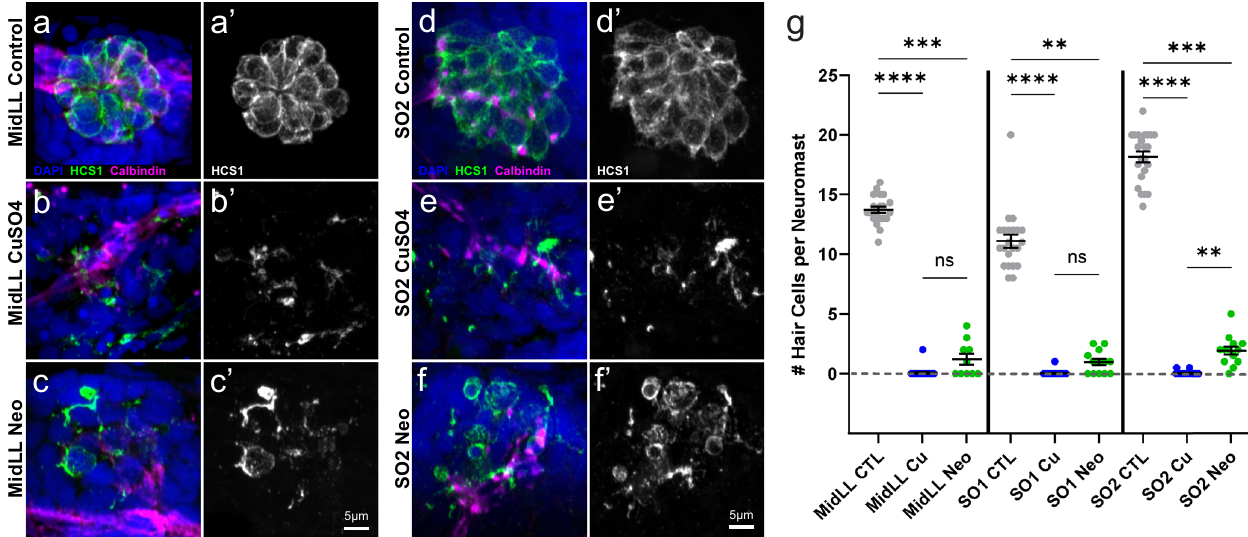
Fig. 2 Con fi rmation of neuromast hair cell loss following CuSO 4 or neomycin treatment. a – f Representative confocal max intensity projection images of the: a – c ) mid posterior lateral line (MidLL) fourth neuromast (L4); and d – f second anterior supraorbital (SO2) neuromast from the fi sh cohorts used for behavior experiments. Hair cells were labeled with an antibody against Otoferlin (HCS1; green a – f , gray a ′ – f ′ ). Afferent neurons were labeled with an antibody against Calbindin (magenta), and cell nuclei were labeled with DAPI (blue). g Quanti fi cation of the grand mean (±SEM) number of hair cells per neuromast in intact (CTL), CuSO 4 - and neomycin-treated fi sh. Each dot represents the mean number of hair cells from the MidLL (L3, L4, and L5) or SO (left and right) neuromasts from an individual fi sh. Data were collected from fi sh used in three experimental behavior trials; n = 4 – 6 fi sh per condition per trial. Signi fi cance values: **<0.01, ***<0.001,